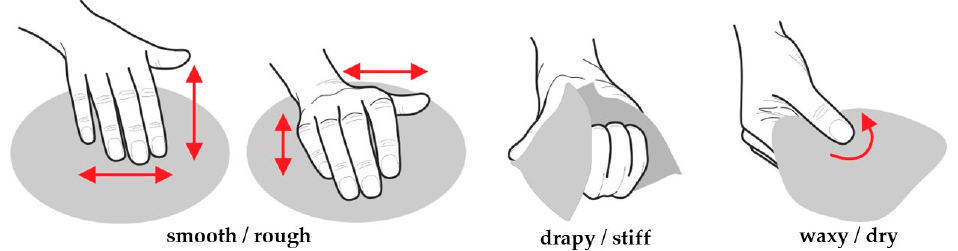
Figure 3. Hand actions in evaluating the respective word pairs.